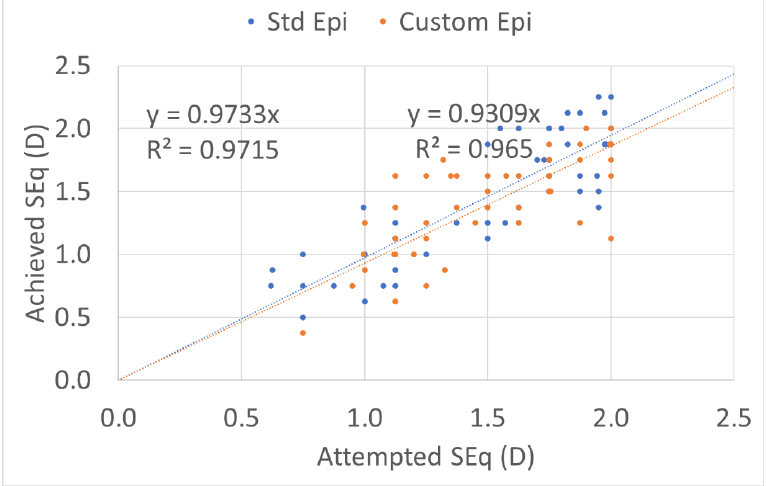
Figure 1. Predictability of the achieved vs. attempted spherical equivalent (SEQ) for both low-myopia groups. The customized epithelium group exhibited a small undercorrection. The regression analysis and R coefficient of determination, in both groups, were near to 1. The predictability of the treatments was similar in the two groups. The scattergram of the achieved vs. attempted correction was very similar for both groups.